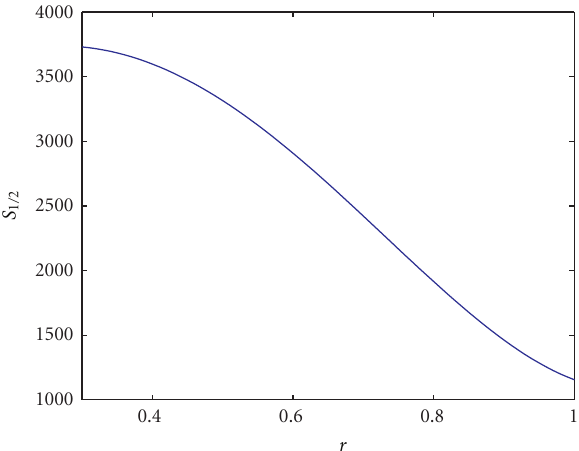
Figure 23: S 1 / 2 of the WMAP team’s Internal Linear Combination (ILC) map, where the octupole components are multiplied by the suppression factor r